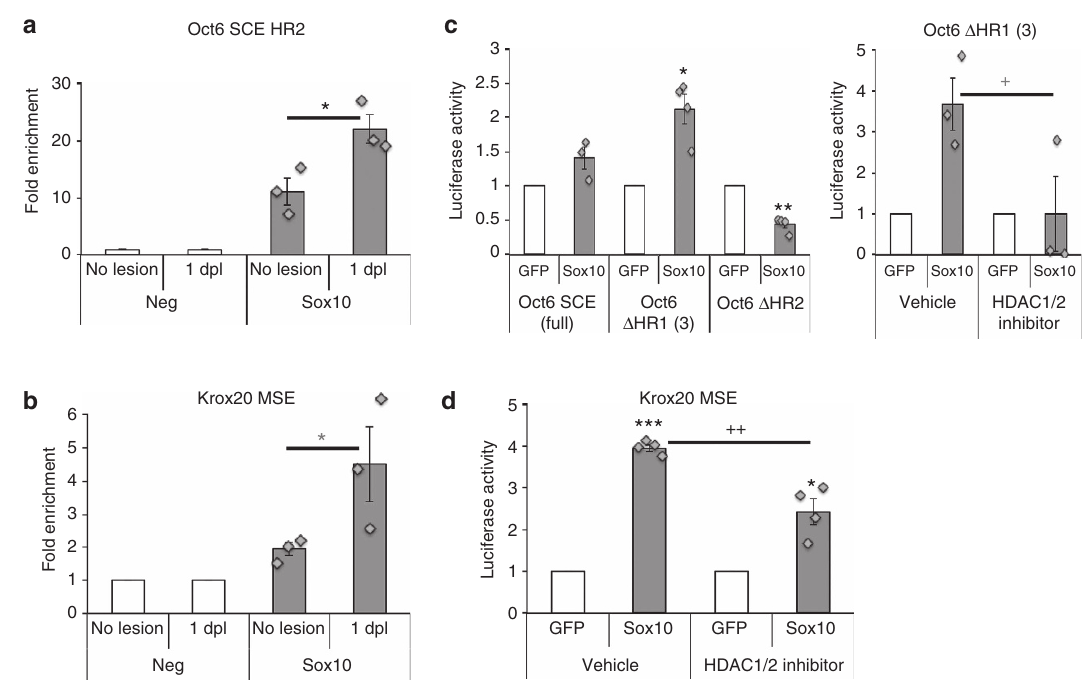
Figure 7 | Oct6 and Krox20 activation by Sox10 depends on HDAC1/2. Chromatin immunoprecipitation of Sox10 and GFP (Neg ¼ 1) in ( a ) unlesioned (no lesion) nerves or at 1 dpl on the Oct6 SCE HR2, or in ( b ) unlesioned nerves or at 12 dpl on the Krox20 MSE. Relative luciferase activity of ( c ) the full Oct6 SCE, the D HR1 (construct #3; ref. 35) and D HR2 SCE, or of ( d ) the Krox20 MSE, in primary RSCs transfected with GFP ( ¼ 1) or Sox10 expression constructs and cultured under dedifferentiating ( c ) or redifferentiating ( d ) conditions for 1 day, in the presence of Mocetinostat (HDAC1/2 inhibitor) or its vehicle ( c , d ). One-tailed (grey asterisk or cross) or two-tailed (black asterisks or crosses) Student’s t -tests, unpaired ( a , b ; c , d : HDAC1/2 inhibitor compared with Vehicle) or paired ( c , d : Sox10 compared with GFP), P values: * P o 0.05, þ P o 0.05; ** P o 0.01, þþ P o 0.01; and *** P o 0.001. Values, mean; error bars, s.e.m. Asterisks show significance compared with no lesion ( a , b ) or to GFP ( c , d ), and crosses compared with Vehicle ( c , d ). Sample size: ( a ) three animals per group no lesion and 1 dpl; ( b ) 3 animals per group no lesion and 12 dpl; ( c ) n ¼ 3 or 4; ( d ) n ¼ 4.